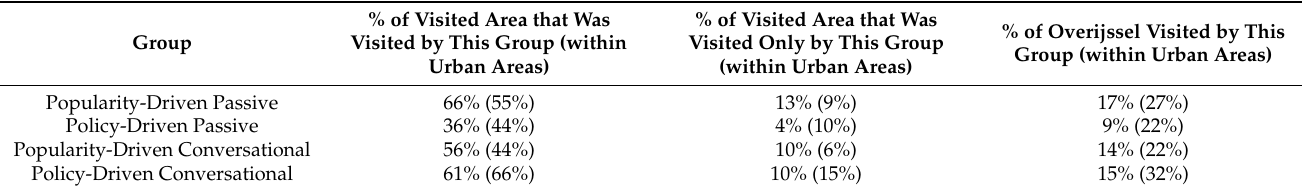
Figure 6. Locations visited exclusively by each of the 2 policy-driven groups.